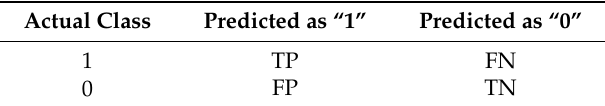
Table 6. Classifier confusion matrix.